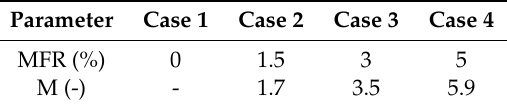
Table 1. Coolant injection